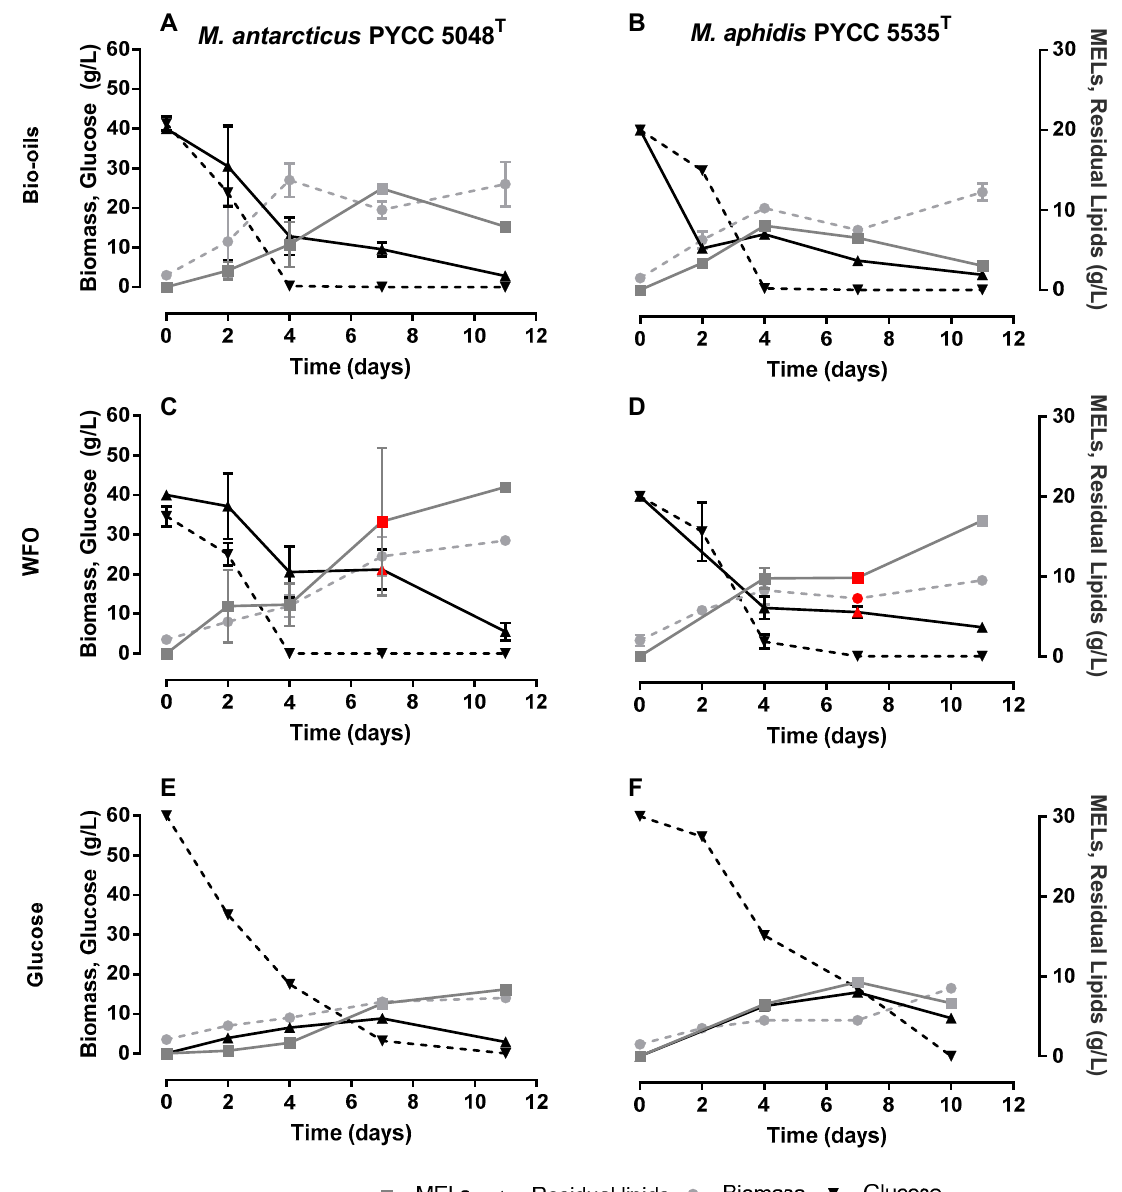
Figure 4. Cultivation of M. antarcticus PYCC 5048T ( A , C , E ) and M. aphidis PYCC 5535T ( B , D , F ) using D-glucose (40 g/L) and a hydrophobic source (20 g/L): Algae-derived bio-oil ( A , B ) and waste frying oil ( C , D ) or 60 g/L of D-glucose ( E , F ) with no further addition of hydrophobic carbon source. The points in red indicate the presence of beads enriched in MELs in the media. Standard deviations values lower than 1 g/L are not represented.